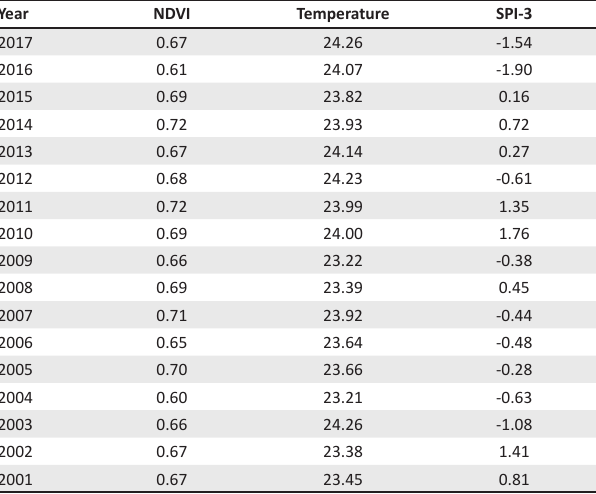
TABLE 1: Normalised difference vegetation index, temperature, and standardised precipitation index for 2001–2017.